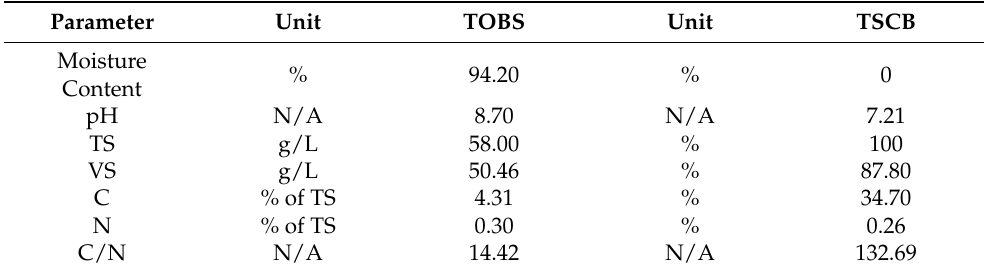
Table 2. The main ultimate and proximate analysis of treated oily-biological sludge (TOBS) and treated dry sugarcane